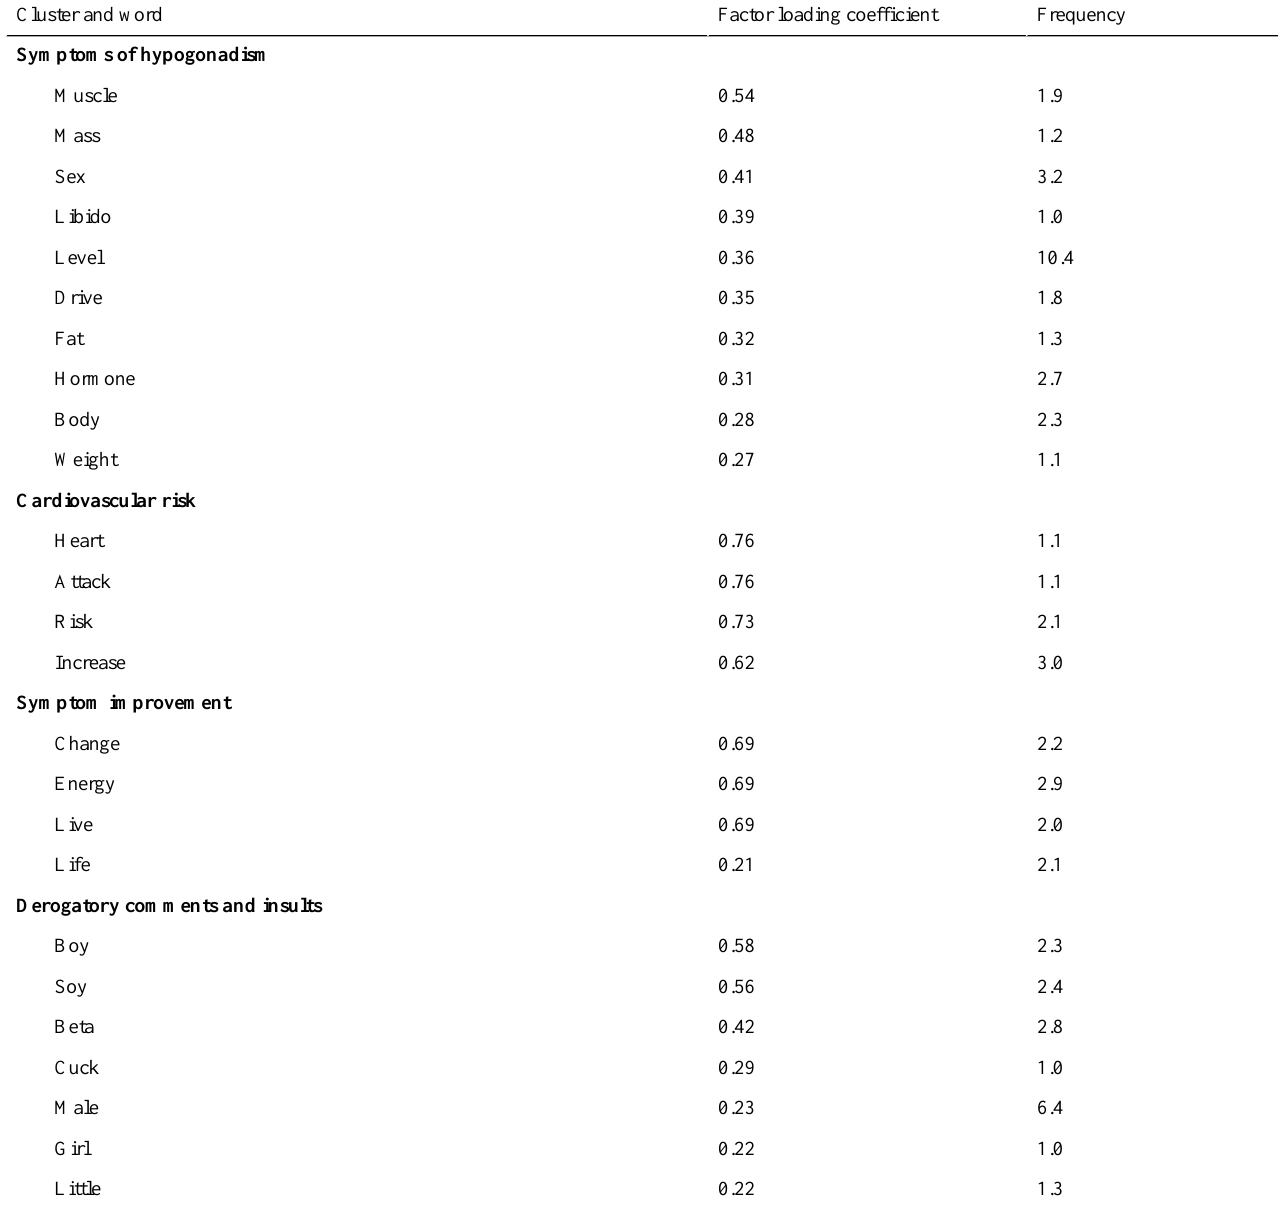
Table 4. Thematic clusters, word frequencies, and associated factor loading coefficients derived from the meaning extraction method with principal component analysis of tweets about low testosterone, low T, or testosterone replacement on Twitter